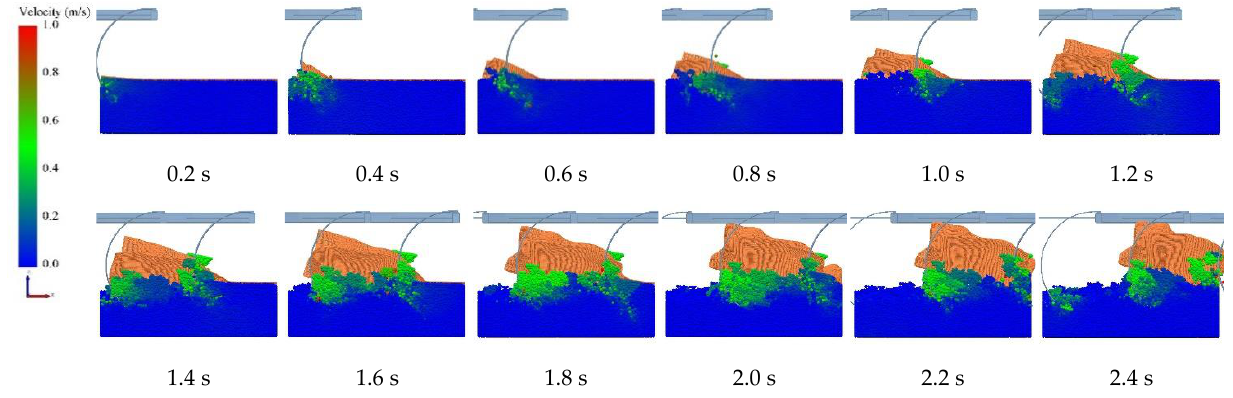
Figure 7. Soil disturbance and migration behaviors at different times under the action of the elastic teeth film-lifting parts.